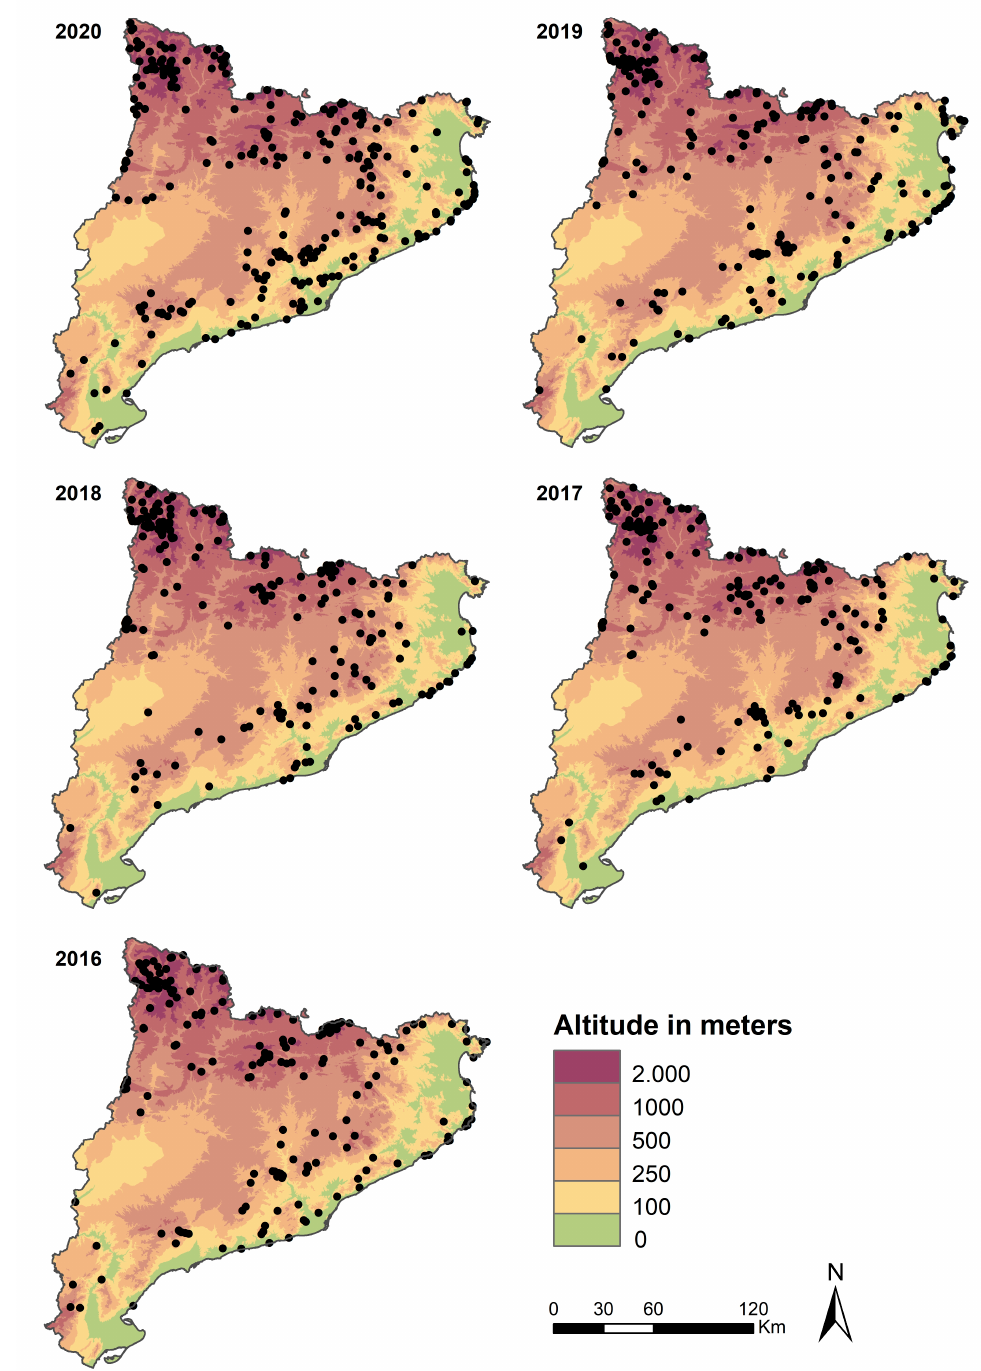
Figure 5. Spatial distribution of rescues and their altitude.